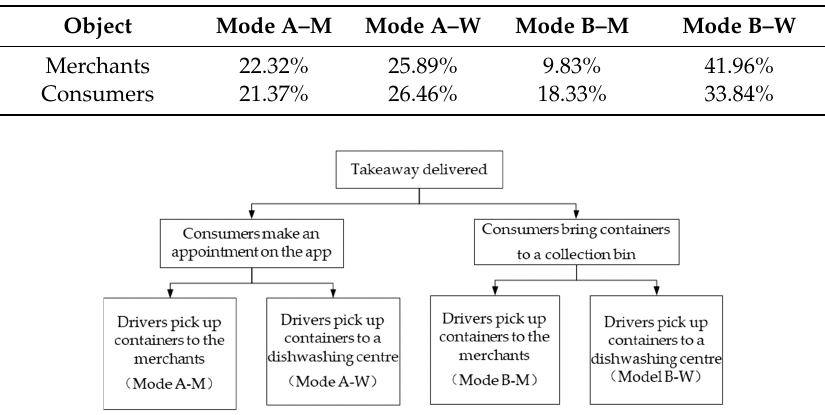
Figure 3. Determined collection modes.